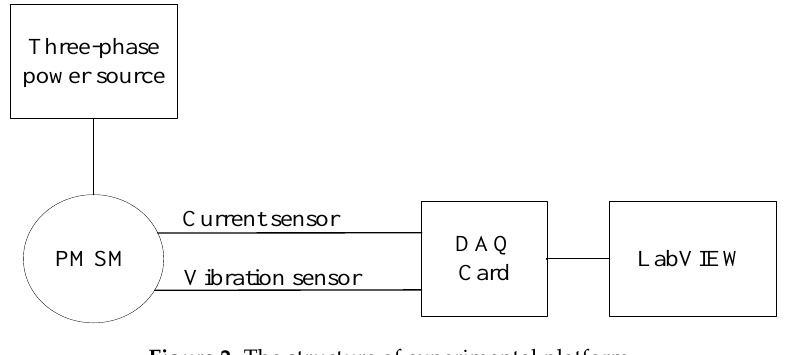
Figure 2. The structure of experimental platform.